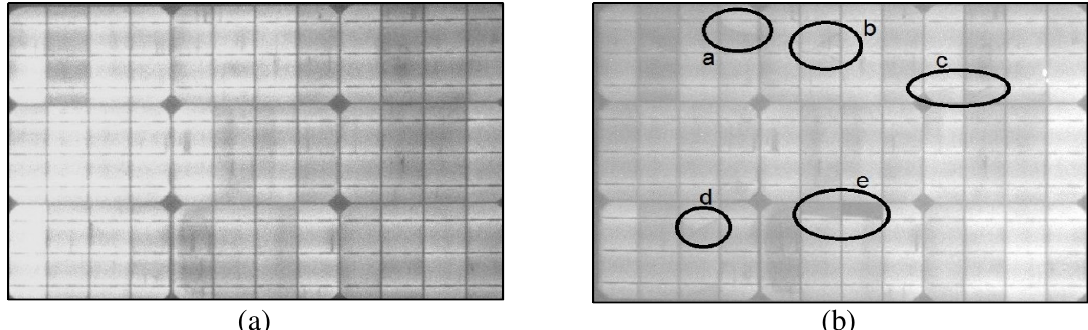
Fig. 4: Electroluminescence images of module 3: (a) before mechanical test and (b) after mechanical test